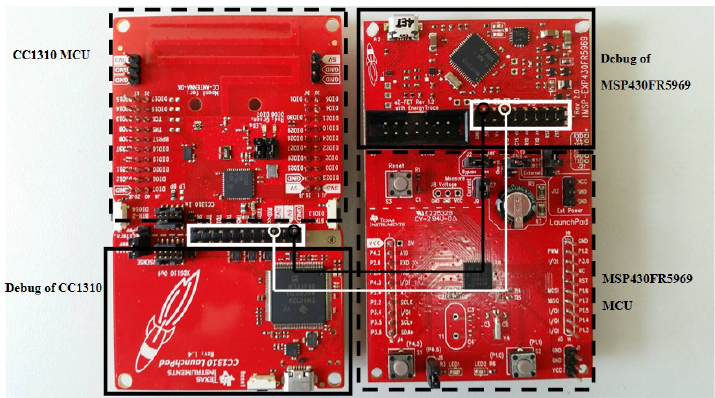
Figure 3. Board configuration for measuring energy